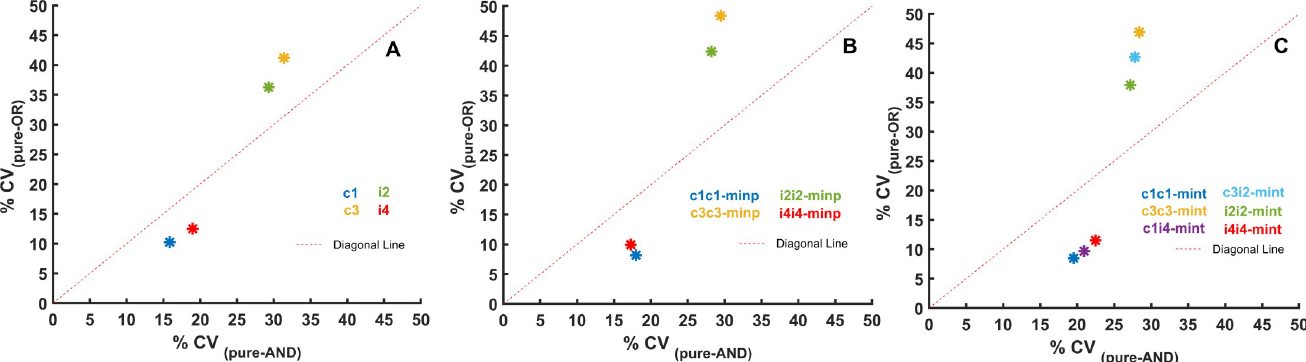
Fig 6. Comparison between the noise reducing capabilities of FFLs containing AND and OR logic gates. Data from Figs 2D and 3 are displayed to show how the coefficient of variation (% CV) of AND gate containing networks compare to OR gate driven networks. OR gate containing networks show a lower CV% than AND gate networks (are below the diagonal) and this finding holds true for simple FFLs (A), multi-input (B), and multi-intermediate (C) coupled FFLs. All FFL combinations where both OR and AND gates are possible are plotted. The fixed parameter sets given in the S1 Text were used in all simulations.